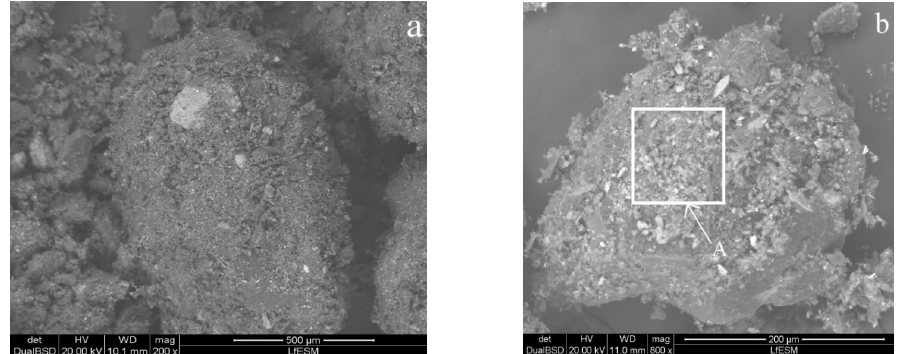
Figure 1. ( a ) SEM image of the anthracite particles, magni fi cation 200×. ( b ) SEM image of anthracite particle with a spot of the EDS spectrum (A), magni fi cation 800×. The surface of the particles of the calcined petroleum coke sample was smooth, fl aky, and cracked, as shown in Figure 2b.